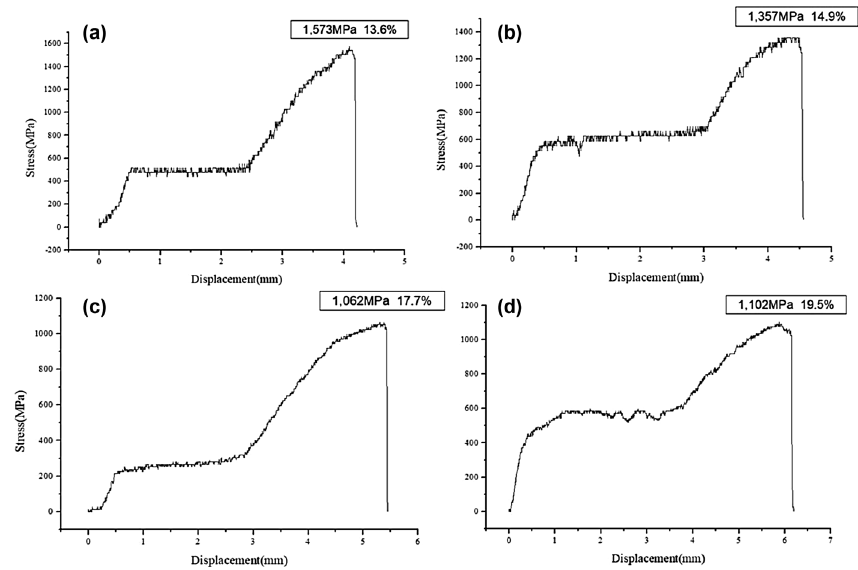
Fig. 6 Tensile test results of the shape memory alloy wire: 0.3 mm, 22 ℃ ( a ); 0.3 mm, 45 ℃ ( b ); 0.5 mm, 22 ℃ ( c ); and 0.5 mm, 45 ℃ ( d )